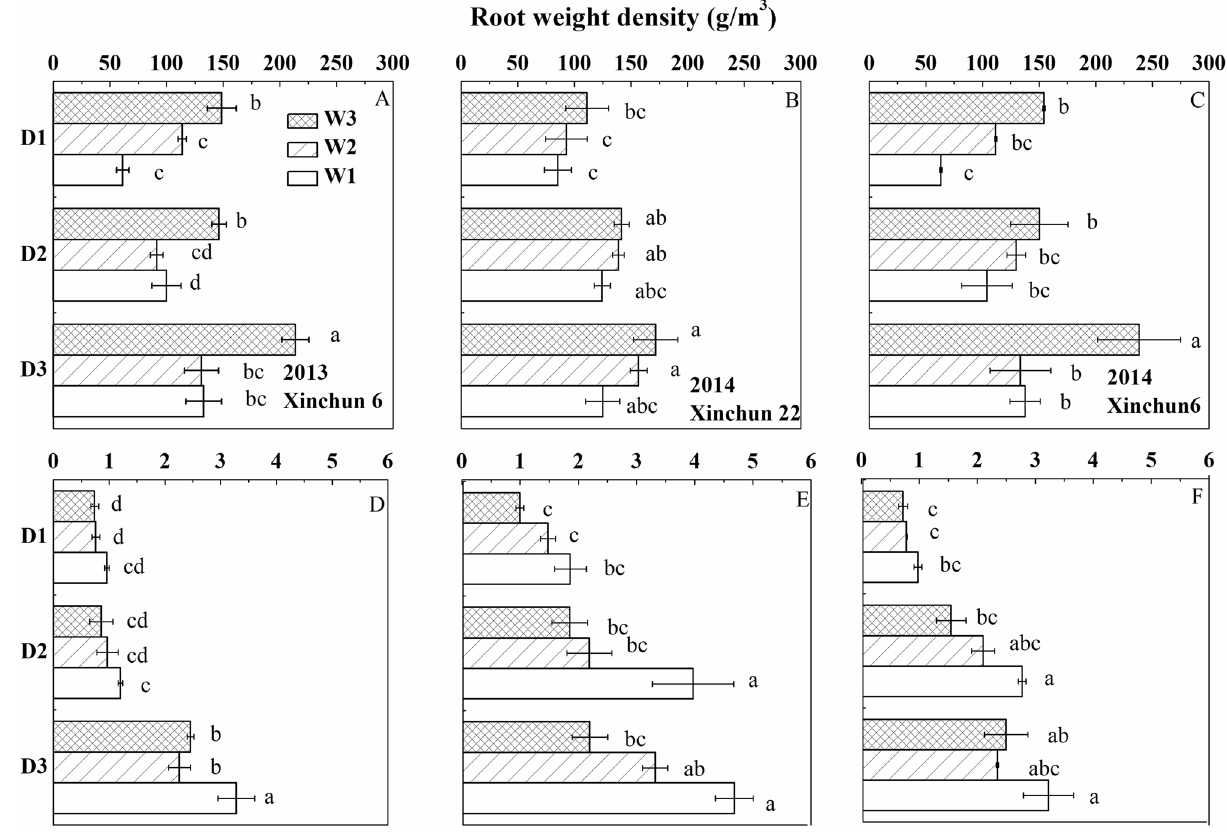
Figure 5. Root weight density at flowering as affected by irrigation frequency and amount. ( A ) The root weight density of ‘Xinchun 6’ in the 0–20 cm depths in 2013. ( B ) The root weight density of ‘Xinchun 22’ in the 0–20 cm depths in 2014. ( C ) The root weight density of ‘Xinchun 6’ in the 0–20 cm depths in 2014. ( D ) The root weight density of ‘Xinchun 6’ in the 20–40 cm depths in 2013. ( E ) The root weight density of ‘Xinchun 22’ in the 20–40 cm depths in 2014. ( F ) The root weight density of ‘Xinchun 6’ in the 20–40 cm depths in 2014. Error bars represent ± SE (n = 10). Bars within a panel with a different letter are significantly different at P <